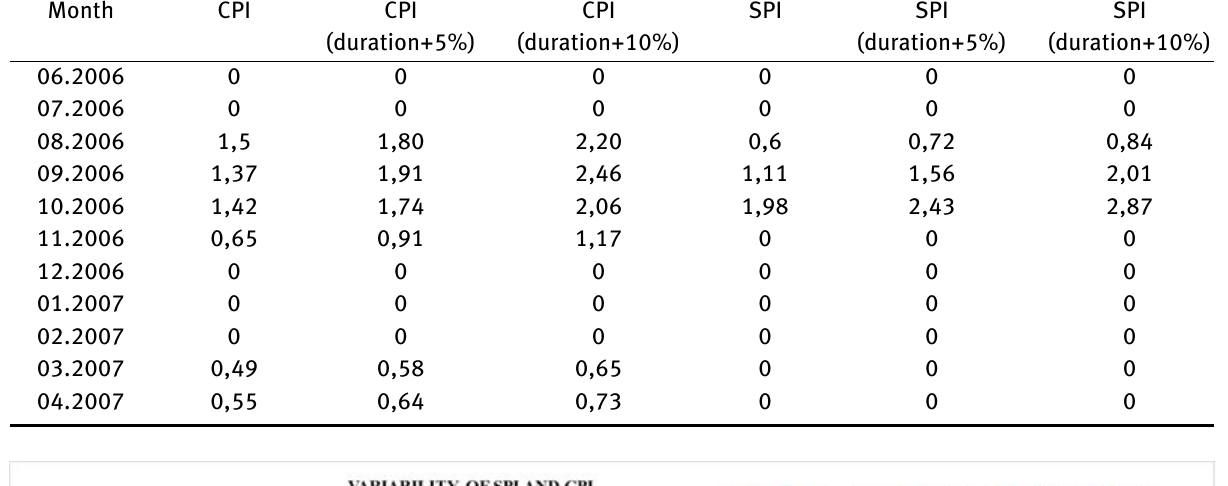
Table 3: Changes of SPI and CPI values [authors’ data] Month